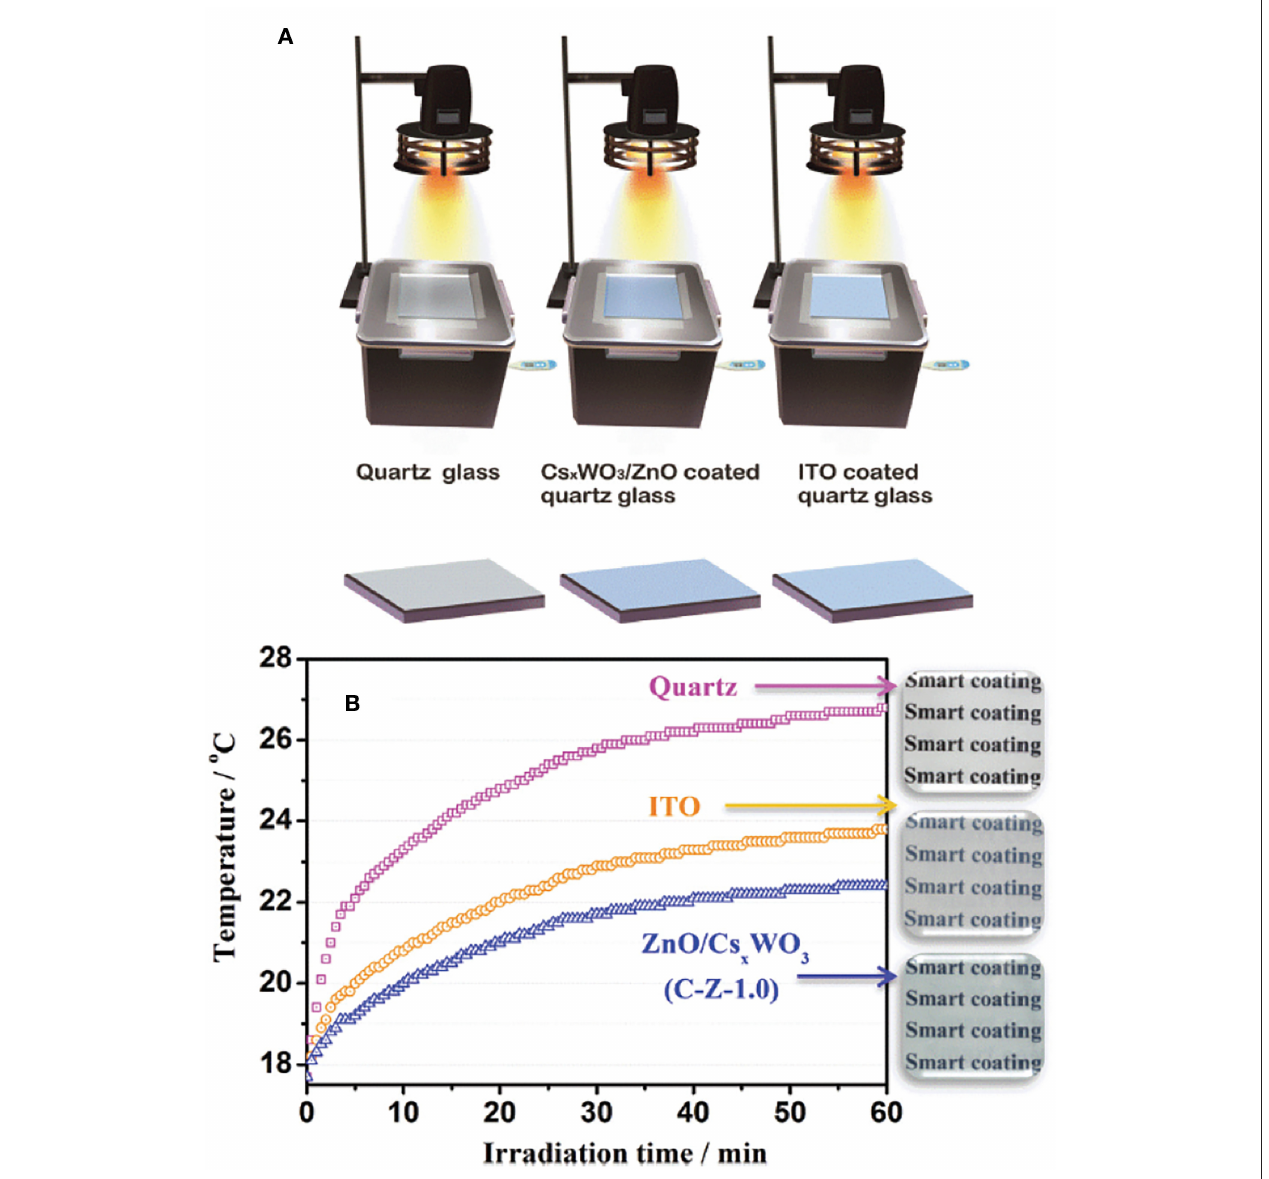
FIGURE 5 | (A) Schematic illustration of the simulated heat ray shielding test using the boxes with facet covered by pure quartz glass, WO 2.72 nanorods coated on quartz glass and ITO glass under the irradiation of a 50W halogen lamp, and the temperature changes were determined by an electronic thermometer. (B) Time dependence of the temperature in the box. Reproduced with permission (Guo et al., 2012c) Copyright 2012,